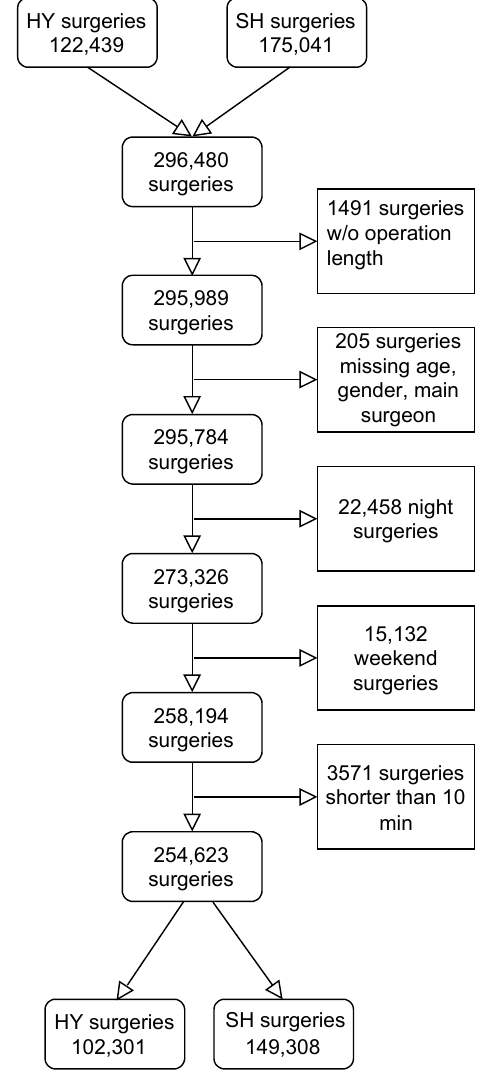
Figure 1. Data selection flow chart.